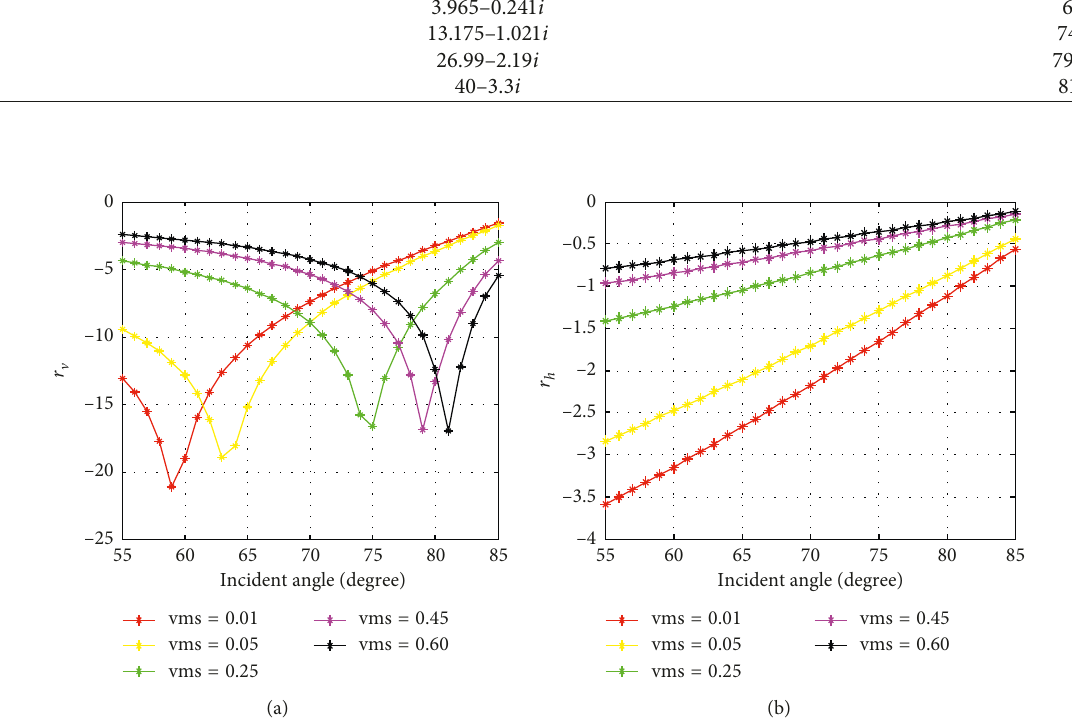
Figure 1: Fresnel reflectivity vs. incident angles: (a) r